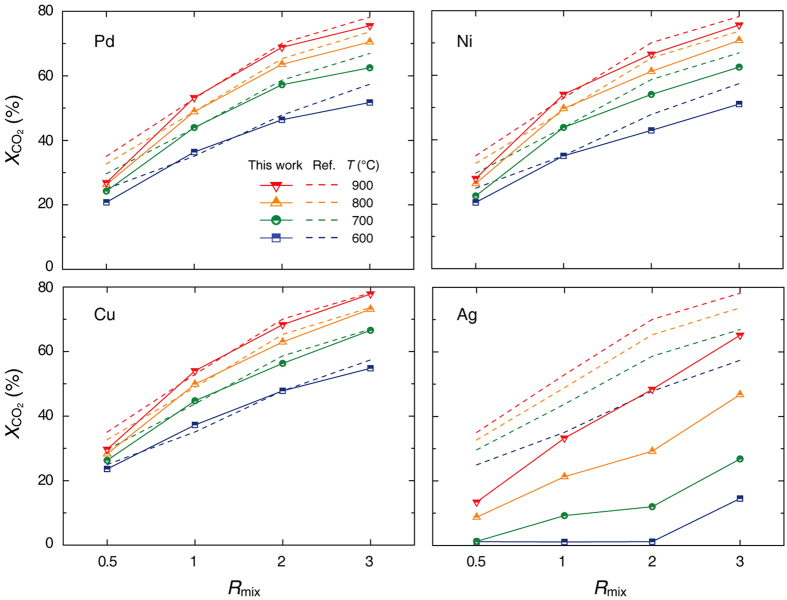
CO2 conversion of each catalyst with respect to temperature and Rmix.The red, yellow, green, and blue lines correspond to temperatures of 900, 800, 700, and 600 °C, respectively. For reference, all Xco2 profiles of the empty tube and Al2O3 support are presented in Fig. S2 (Supplementary Information).